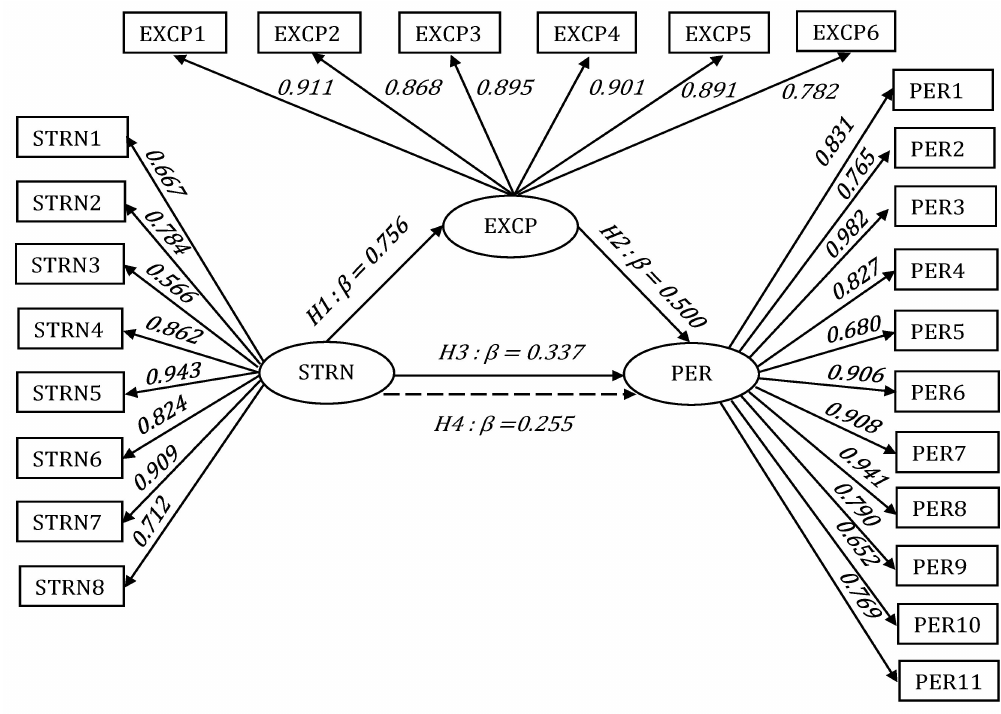
Figure 2. Finalized model.